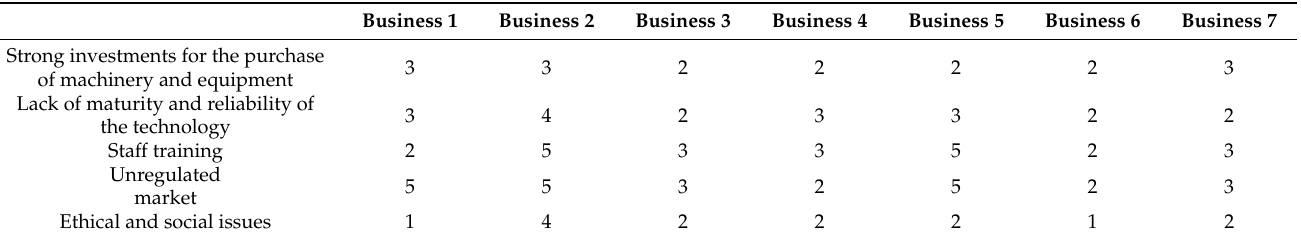
Table 7. Companies perception on the negative impacts and criticalities generated by the use of 3D printers in the medical